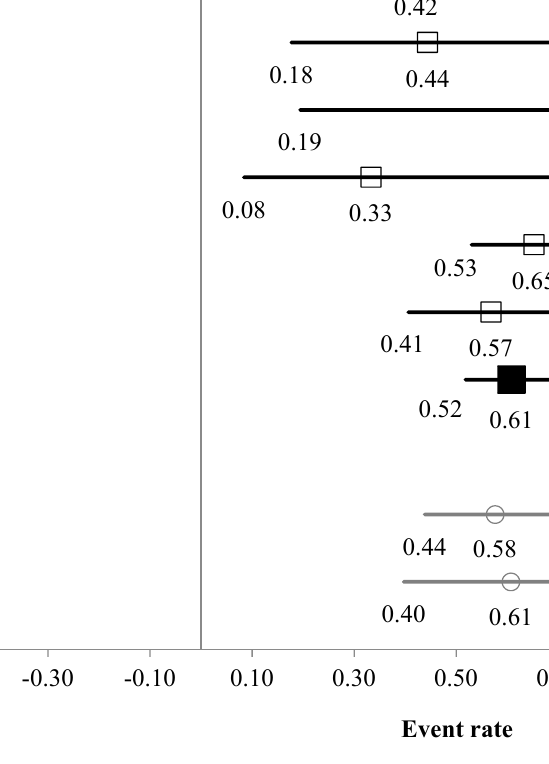
Figure 3. Multi-study event rates ( ± 95% upper and lower limits) for ‘low’ starting wellbeing subsample Figure 3 . Multi-study event rates (±95% upper and lower limits) for ‘low’ starting wellbeing moving to ‘average to high’ wellbeing subsample moving to ‘average to high’ wellbeing post-intervention